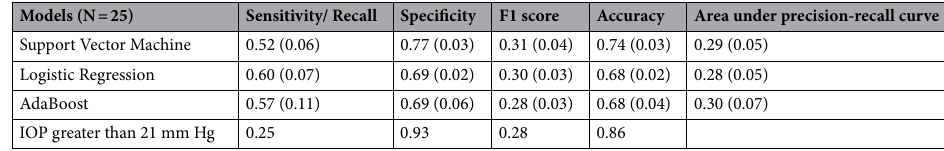
Table 3. Performance metrics reported as mean (standard deviation) over all the